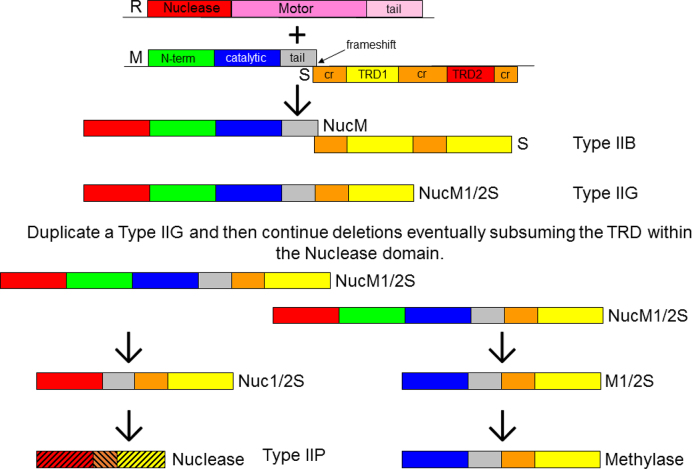
Schematic diagram delineating the steps that could be taken to alter the structure of a Type I RM system to create Type II systems. The colour scheme for domains is the same as in Figure 1. In the step from Nuc\documentclass[12pt]{minimal}
\usepackage{amsmath}
\usepackage{wasysym} 
\usepackage{amsfonts} 
\usepackage{amssymb} 
\usepackage{amsbsy}
\usepackage{upgreek}
\usepackage{mathrsfs}
\setlength{\oddsidemargin}{-69pt}
\begin{document}
}{}$^{1}\!\!/_{\!2}$\end{document}S to Nuclease, the domains are merging together so are shown with hatching.